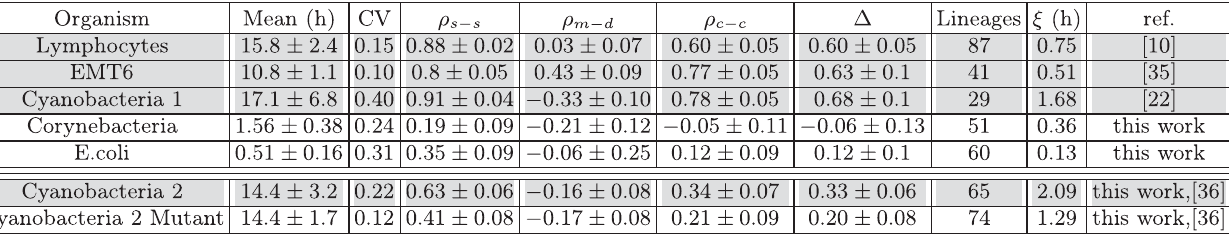
TABLE I. Typical experimental measures of the cell-cycle duration and correlations in various organisms (see also Table III). Mean cell-cycle duration computed on the third generation ( (cid:2) std), coefficient of variation (CV), Spearman correlations, and Δ [as defined by Eq. (7)]. The expected value for Δ for the null model is zero. The noise between sisters cells ξ is defined in Eq. (1) and extracted from the data shown in Fig. 8 (see Sec. V). Data sets that have Δ significantly above zero are marked in grey (see Sec. V for significance